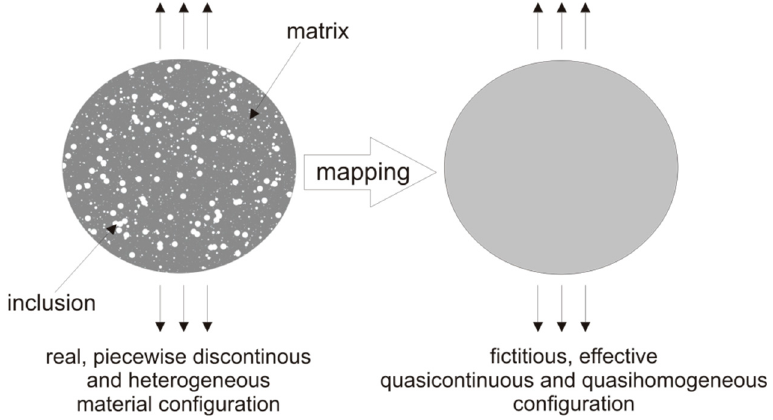
Figure 1. Real and equivalent fictitious continuum.